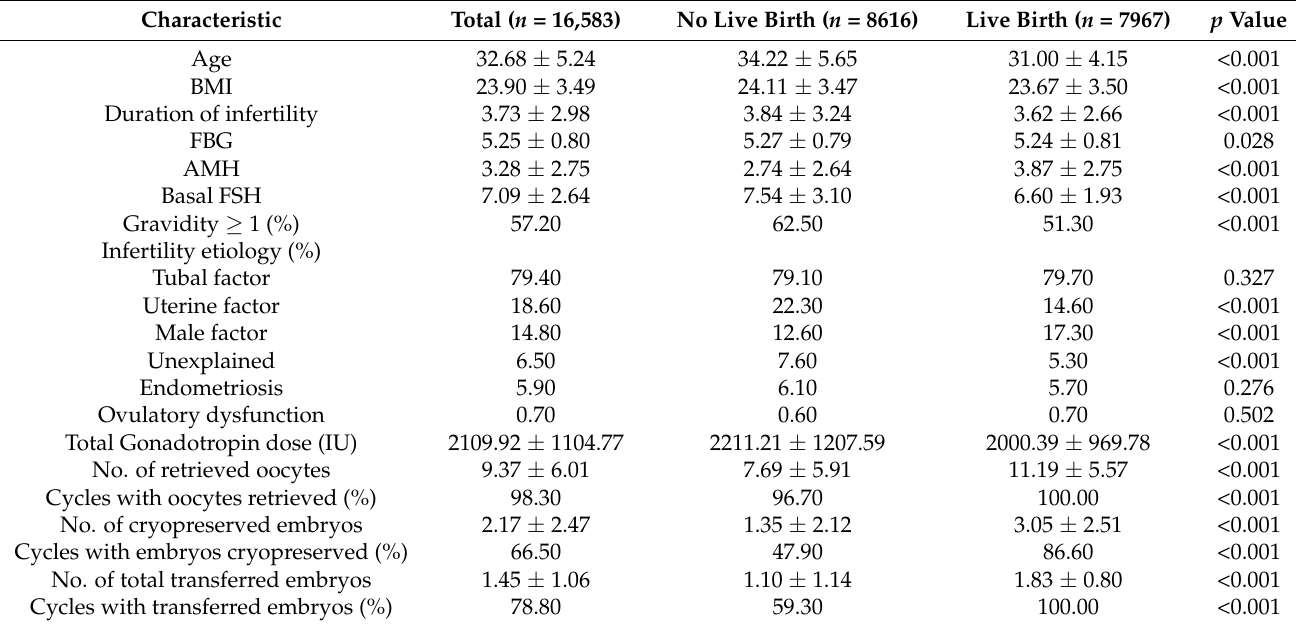
Table 1. Baseline and stimulation cycle